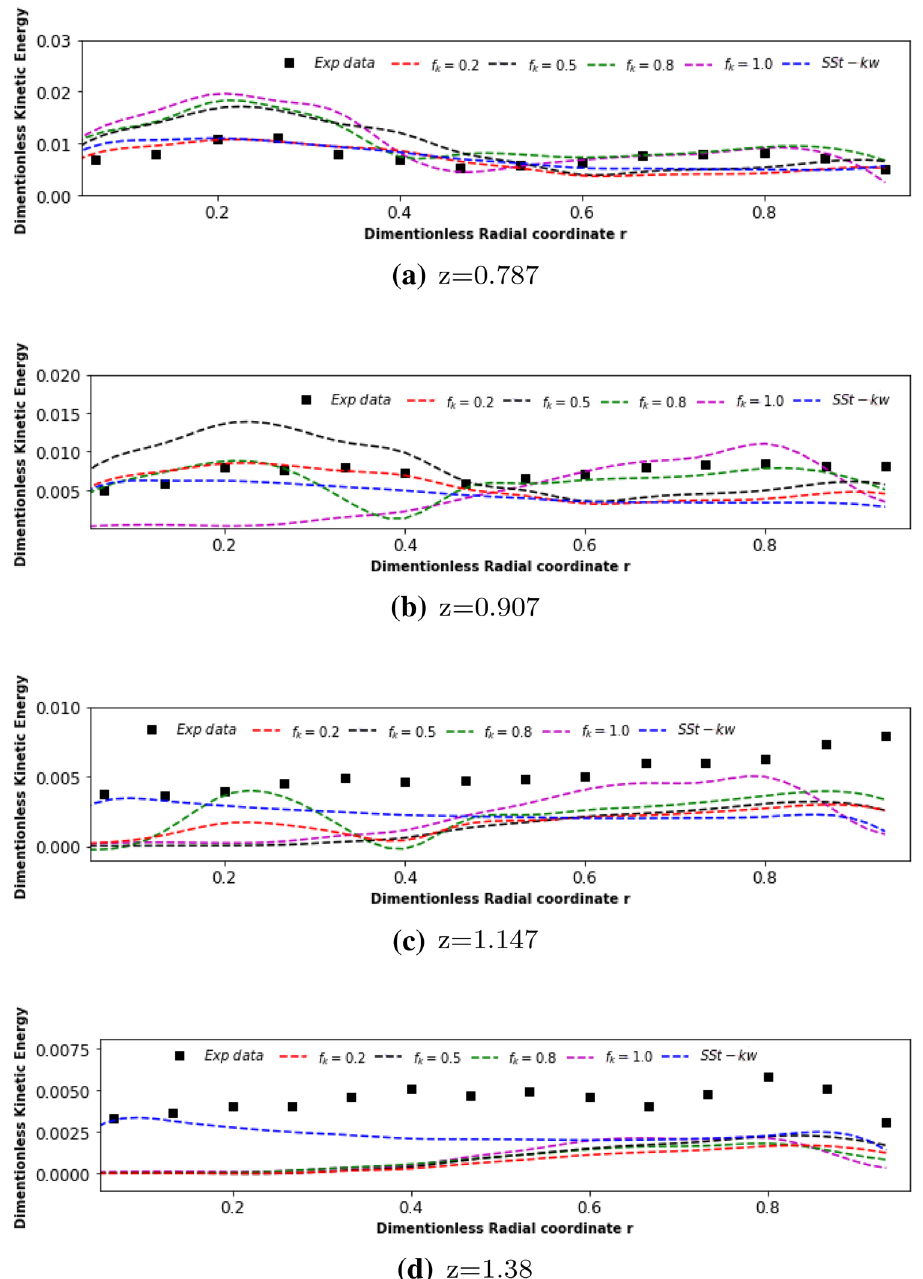
Fig. 11 Turbulent kinetic energy profiles above the impeller at different z-location for f k = 0.2 ( - - - ), f k = 0.5 ( - - - ), = 0.8 ( - - - ), f = 1.0 ( - -- ) of f k k PANS k u − 𝜖 u model, SST k − 𝜔 model ( - - - ) and experimental data ( ▪